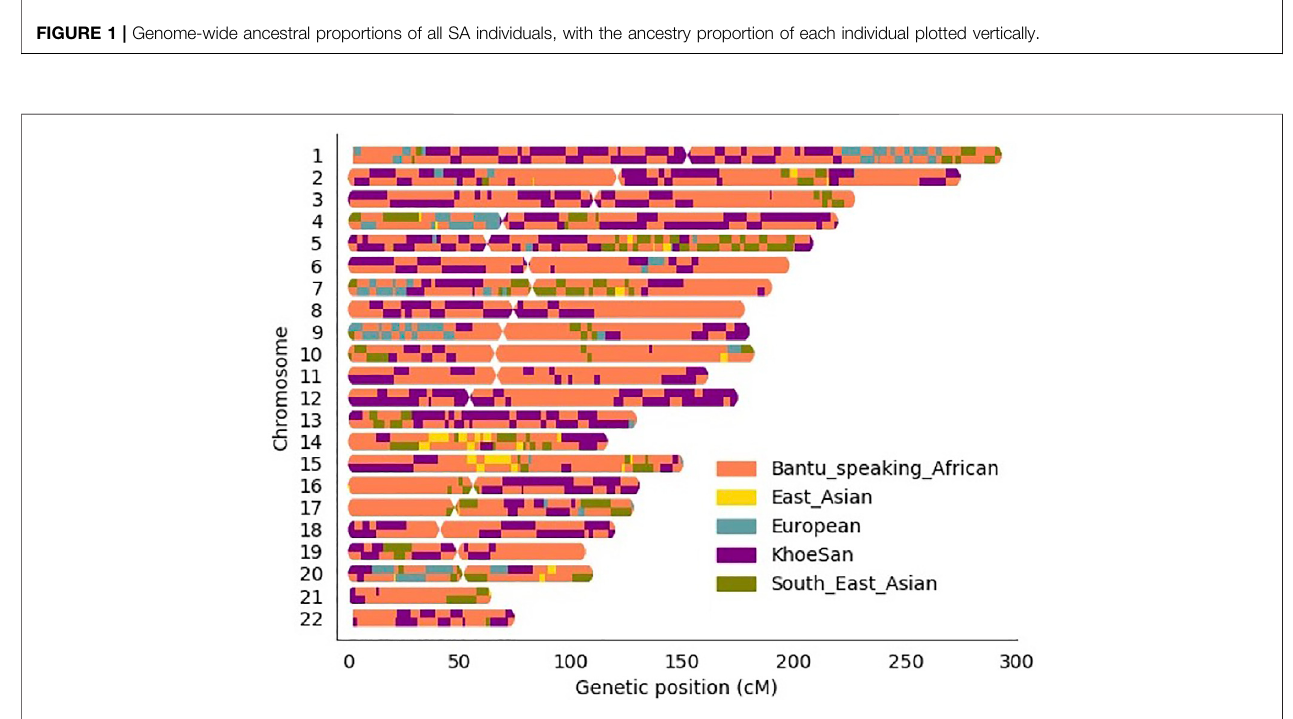
FIGURE 2 | Karyogram of one admixed SA